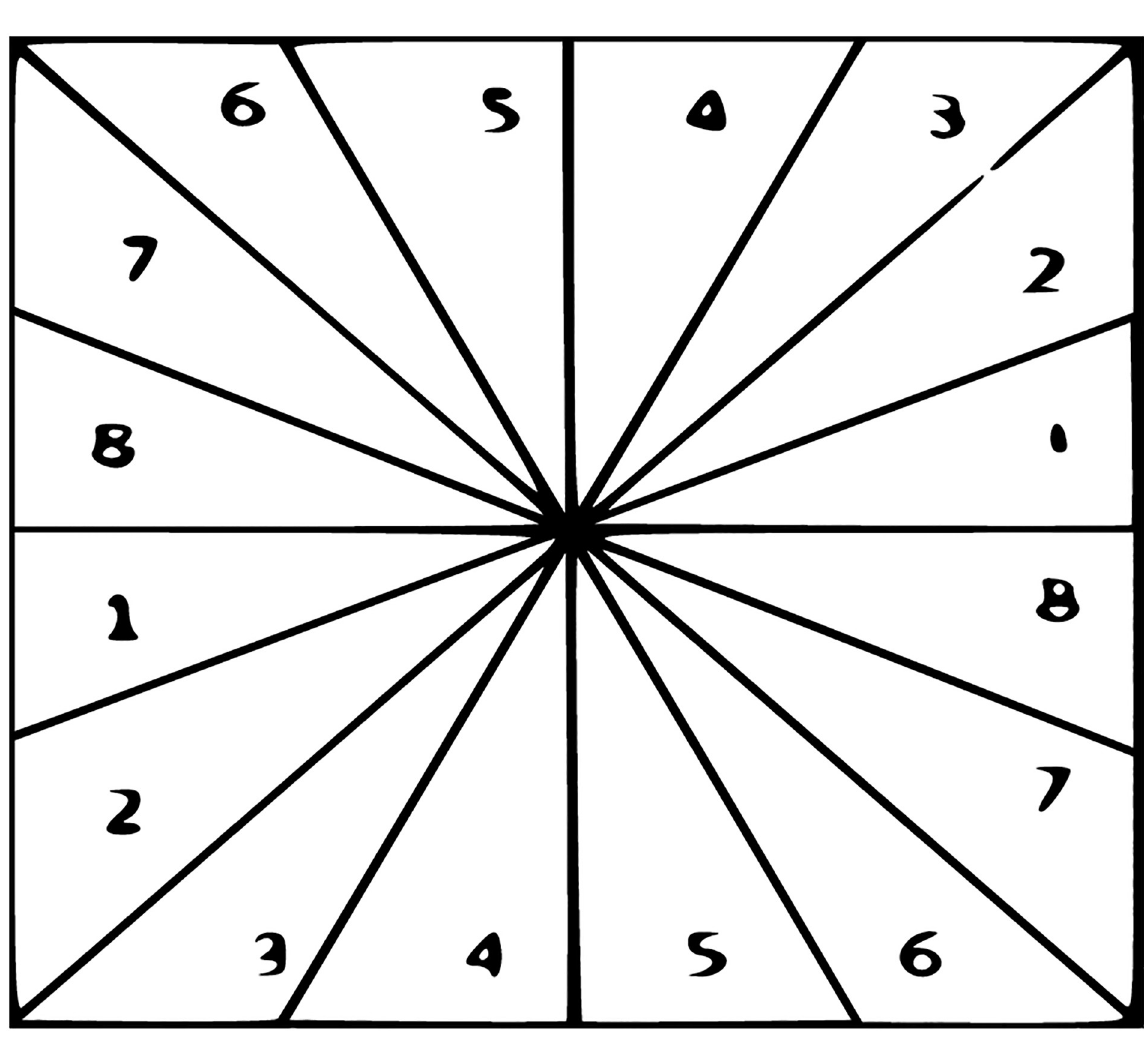
Fig 3. 2D frequency